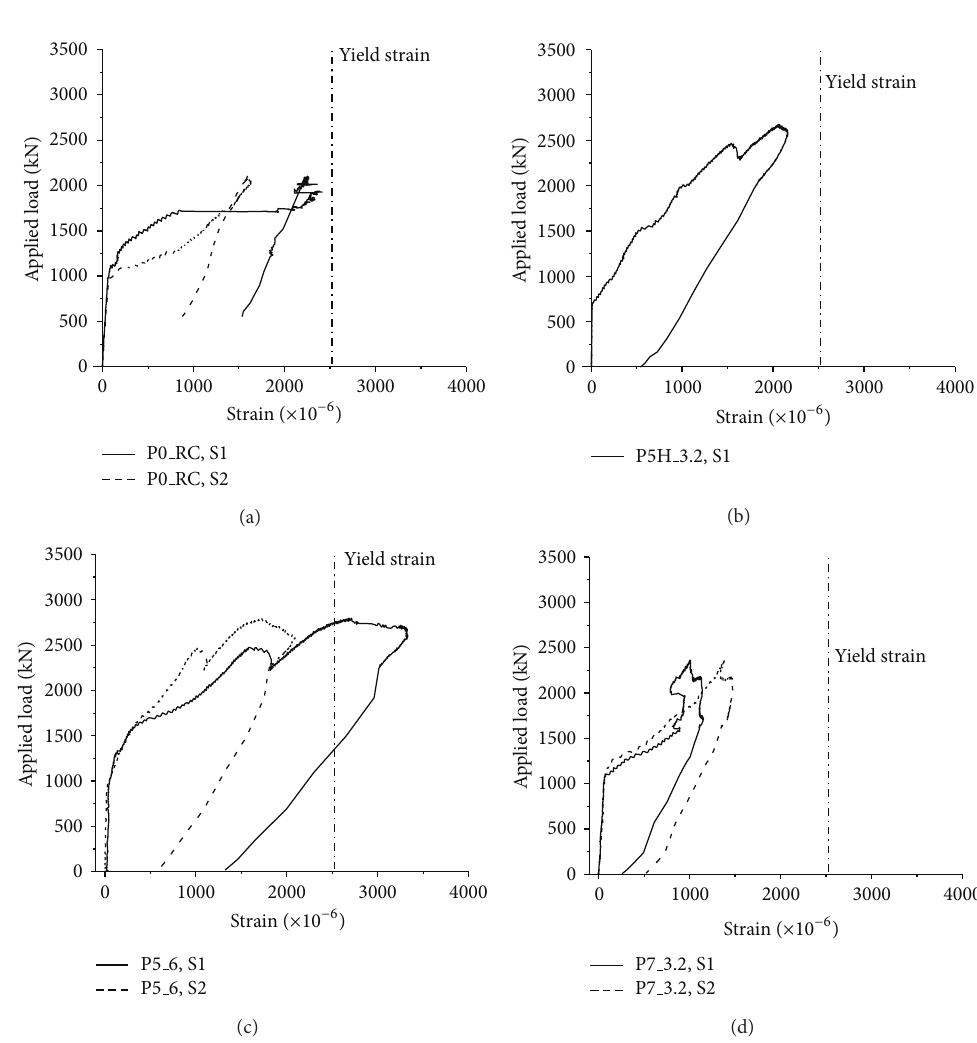
maximum value of 𝑃 ∗ and 𝑃 ∗∗ . 𝑃 ∗ and 𝑃 𝑢 of each of the specimens are shown in Table